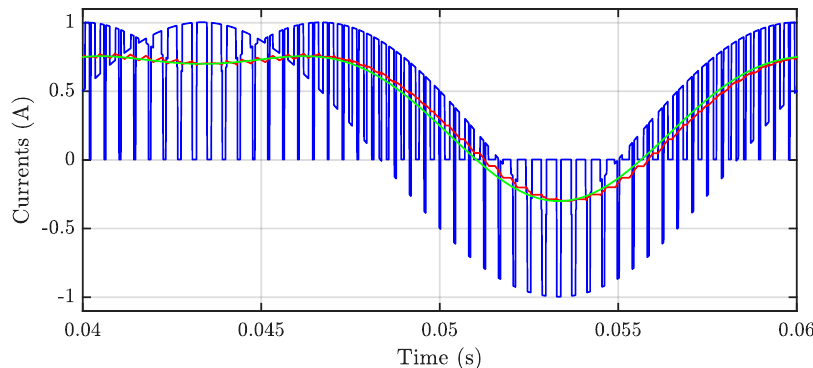
Figure 3. Input current: instantaneous value (blue), its averaged value over the switching period (red), and calculated value (green) in case of unbalanced two phases for m = 0.4, I a = I b = I = 1 A and ϕ = 0°.